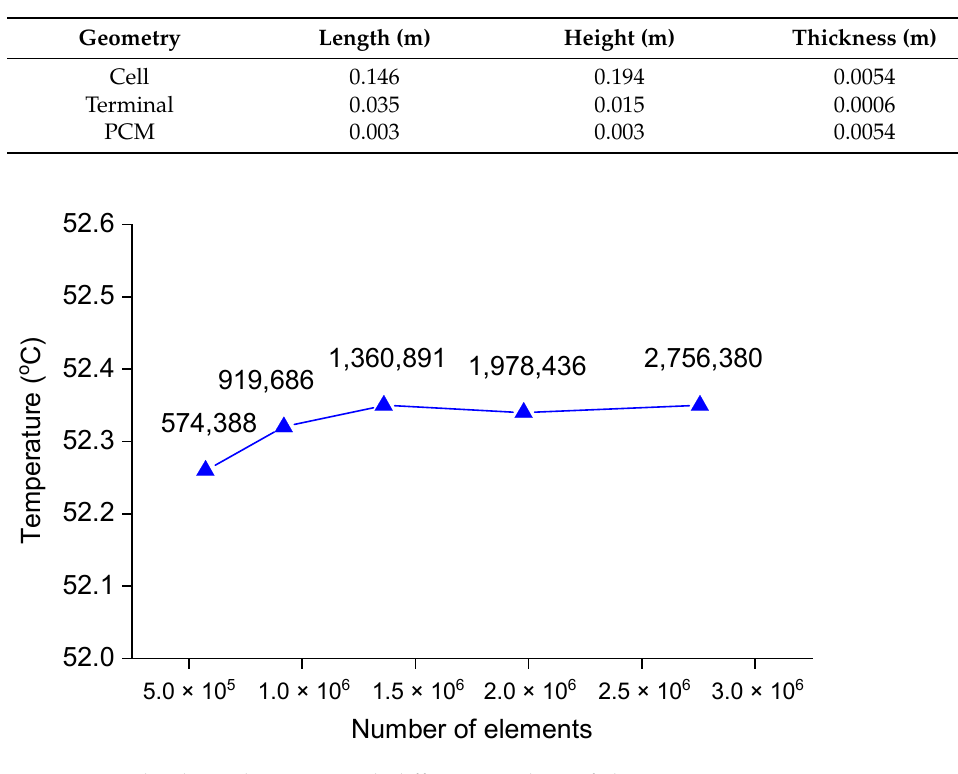
Table 4. Dimensions of the battery and PCM geometry in the simulations of Javani et al. [28].